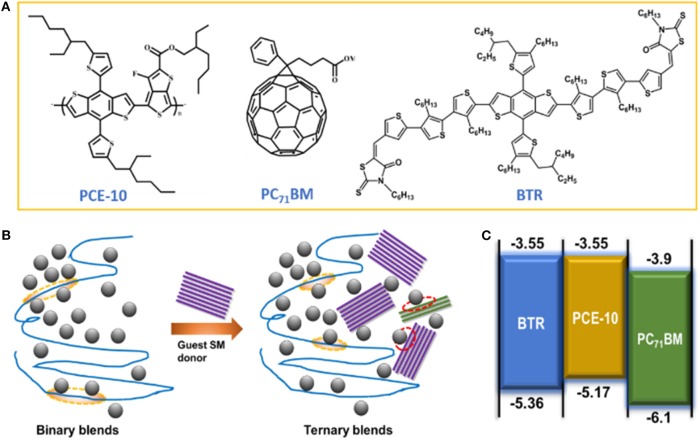
(A) Chemical structures of used components in studied ternary blends. (B) Illustration of binary blends comprising of a polymer donor and fullerene acceptor alongside ternary blends with addition of a third small molecule (SM) acceptor. Also highlighted by ovals are the interfaces between polymer donor/PC71BM (orange) and SM-donor/PC71BM (red). (C) Energy diagram of ternary blends in this study.